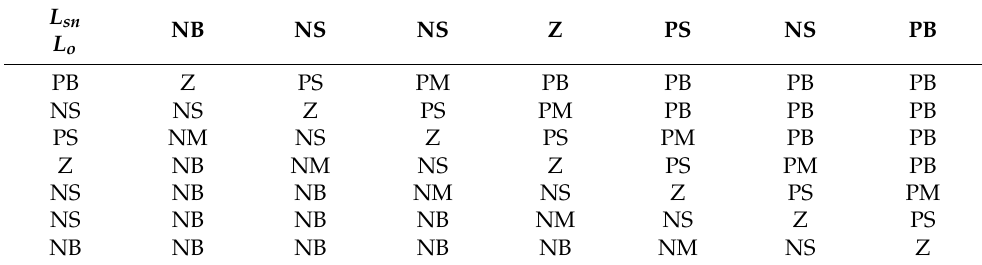
Table 2. Rule base for bounded-layer fuzzy-based SMC.